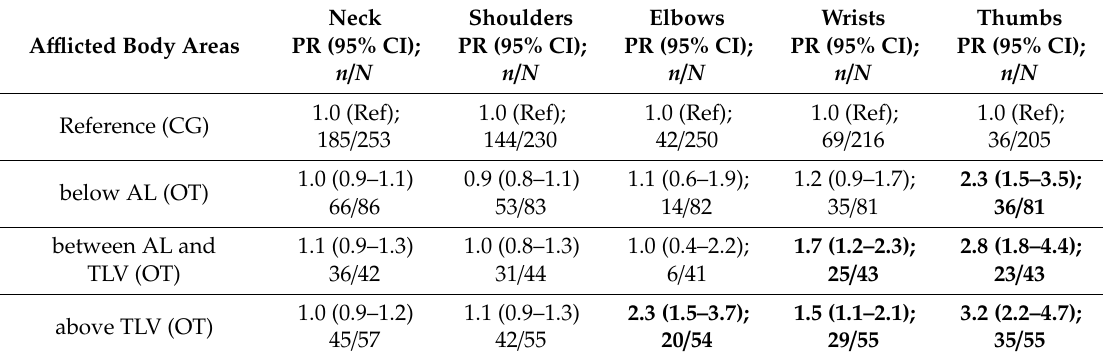
Table 4. Prevalence ratios of musculoskeletal complaints (adjusted PR (95% CI)): occupational therapists grouped by exposure